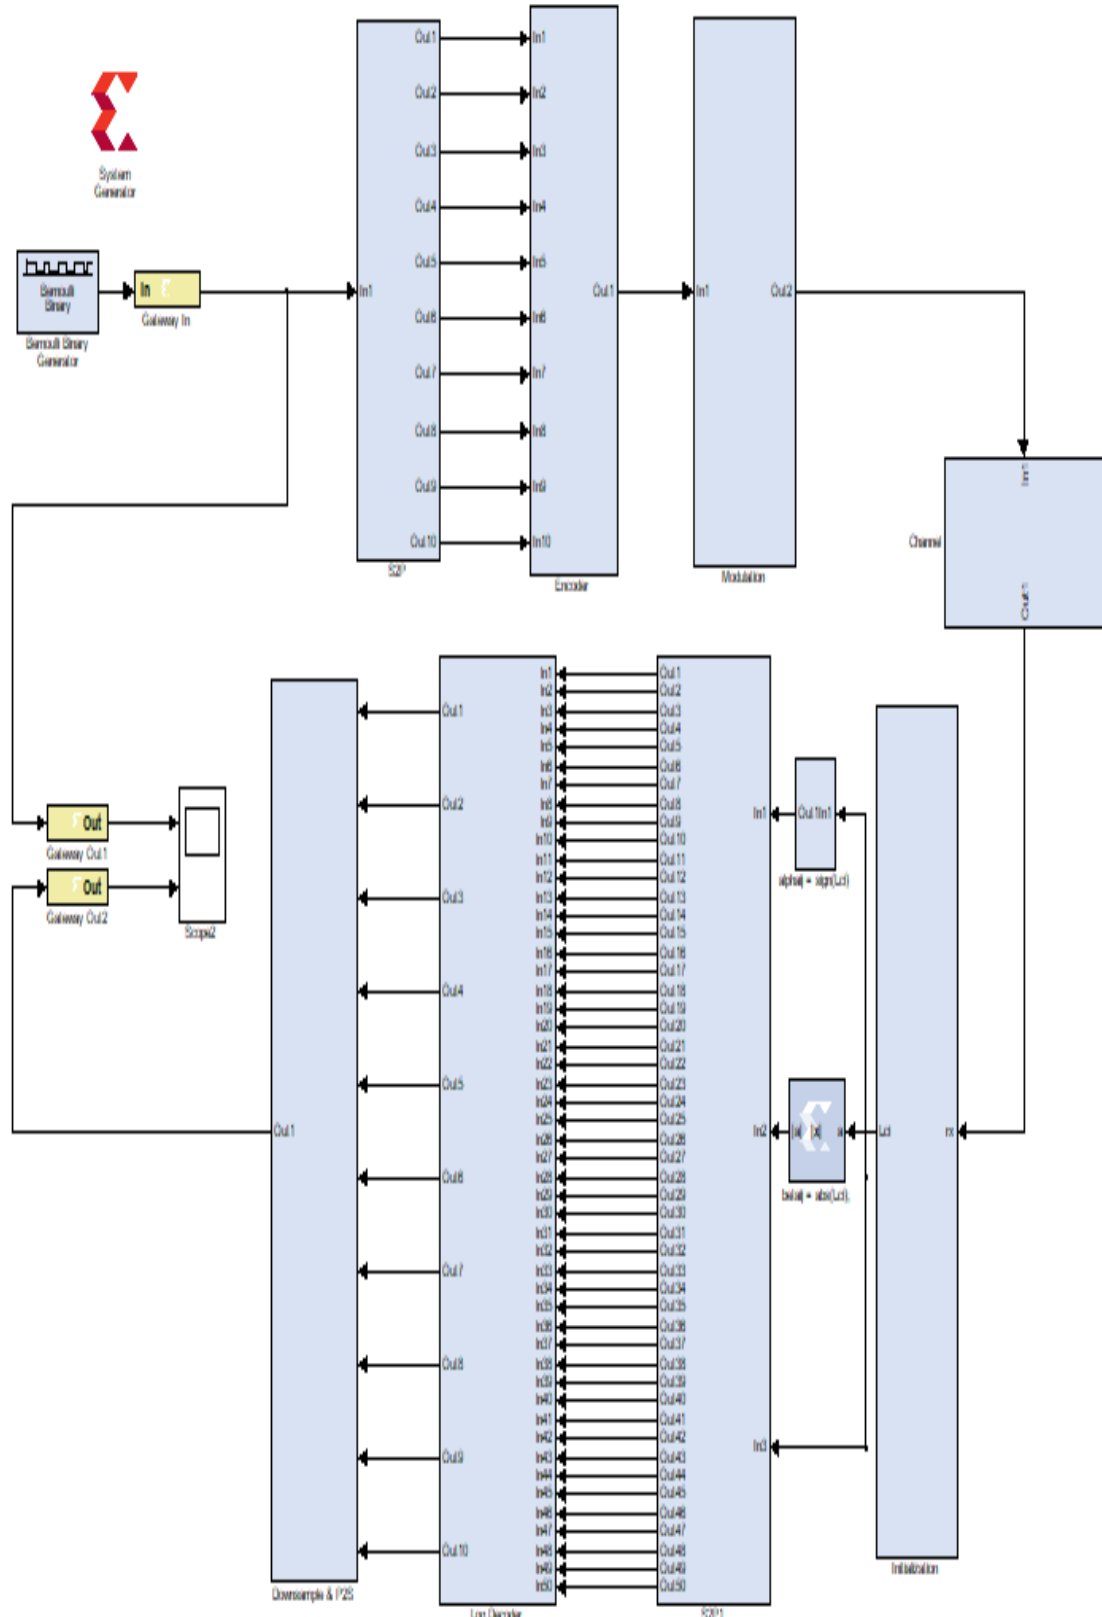
Fig. 3. The Xilinx SG corresponds to the proposed block diagram of Fig.